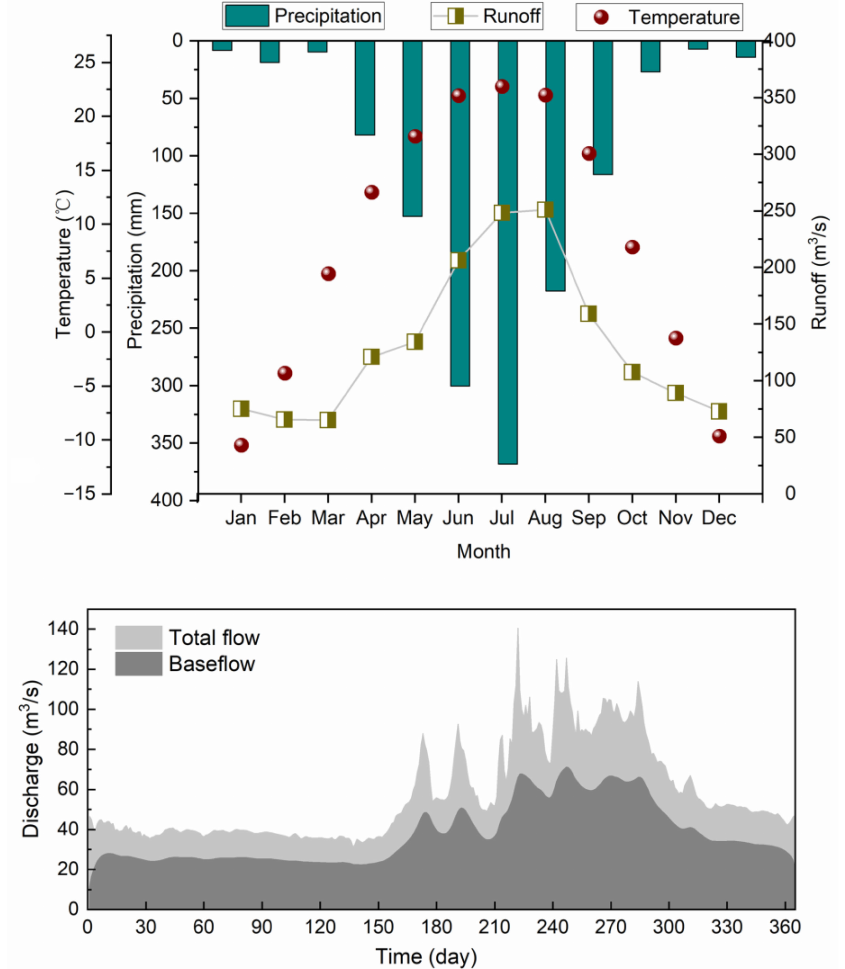
Figure 2. Monthly variations in temperature, precipitation, runoff and baseflow in the Kaidu River. The data for temperature and precipitation are from 2000 to 2018, and the data for runoff are from 1972 to 2012. The baseflow separation of the Kaidu River is the multiyear